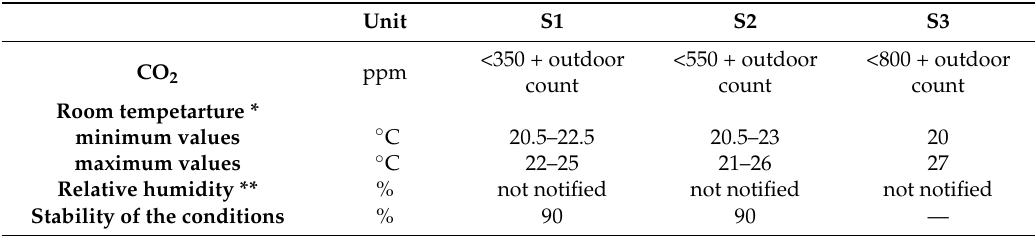
Table 2. The objective values of CO 2 , temperature, and relative humidity of indoor air in Finland according the Finnish Classification of Indoor Environment and Material